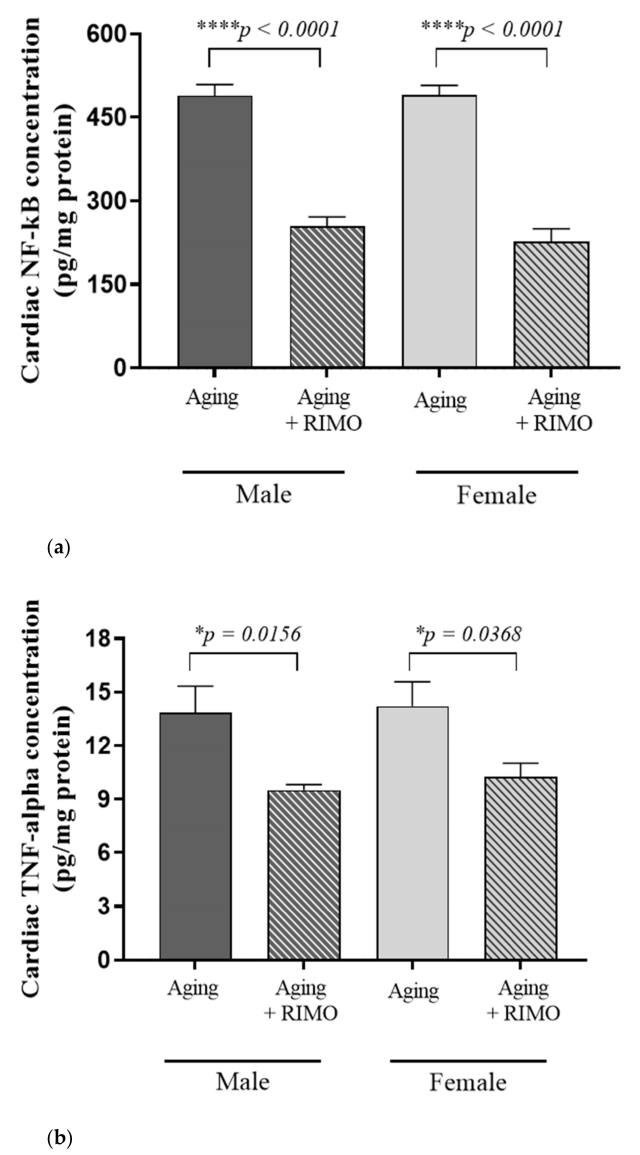
Figure 5. ( a ) The effects of rimonabant treatment on cardiac NF- κ B concentration in aged ani- mals. (NF- κ B; expressed as pg/mg protein). Results are shown as means ± S.E.M. n = 6–8. **** p < 0.0001: Statistical significance between rimonabant-treated and untreated, sex-matched aging rats. RIMO = rimonabant, NF- κ B = nuclear factor-kappa B. ( b ) The effects of rimonabant treatment on cardiac TNF-alpha concentration in aged animals. (TNF- α ; expressed as pg/mg protein). Results are shown as means ± S.E.M. n = 5–9. * p < 0.05: Statistical significance between rimonabant-treated and untreated, sex-matched aging rats. RIMO = rimonabant, TNF- α = tumor necrosis